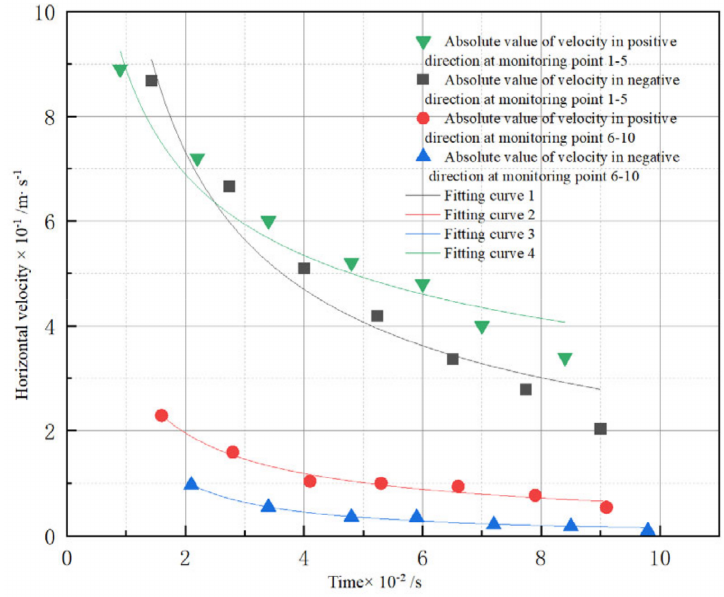
Figure 17. Fitting